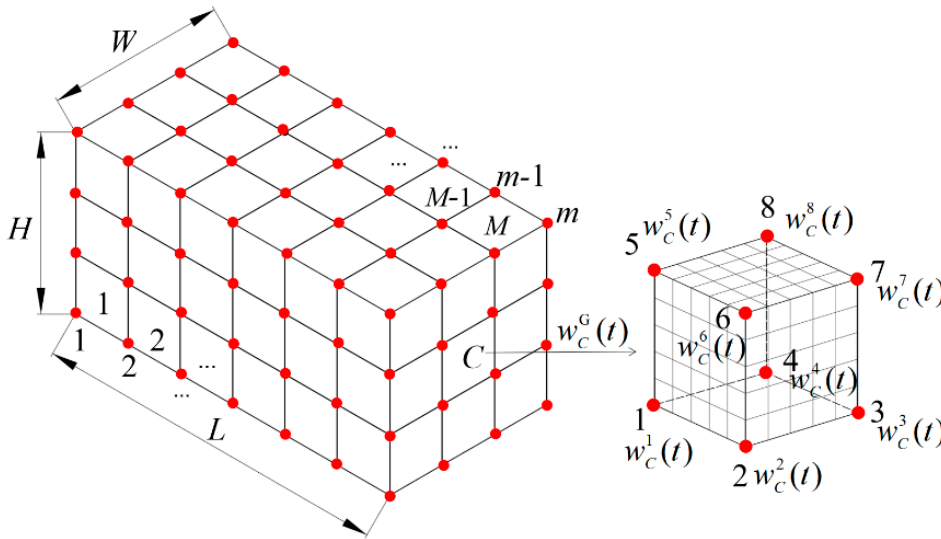
Figure 3. Definition of design variables.